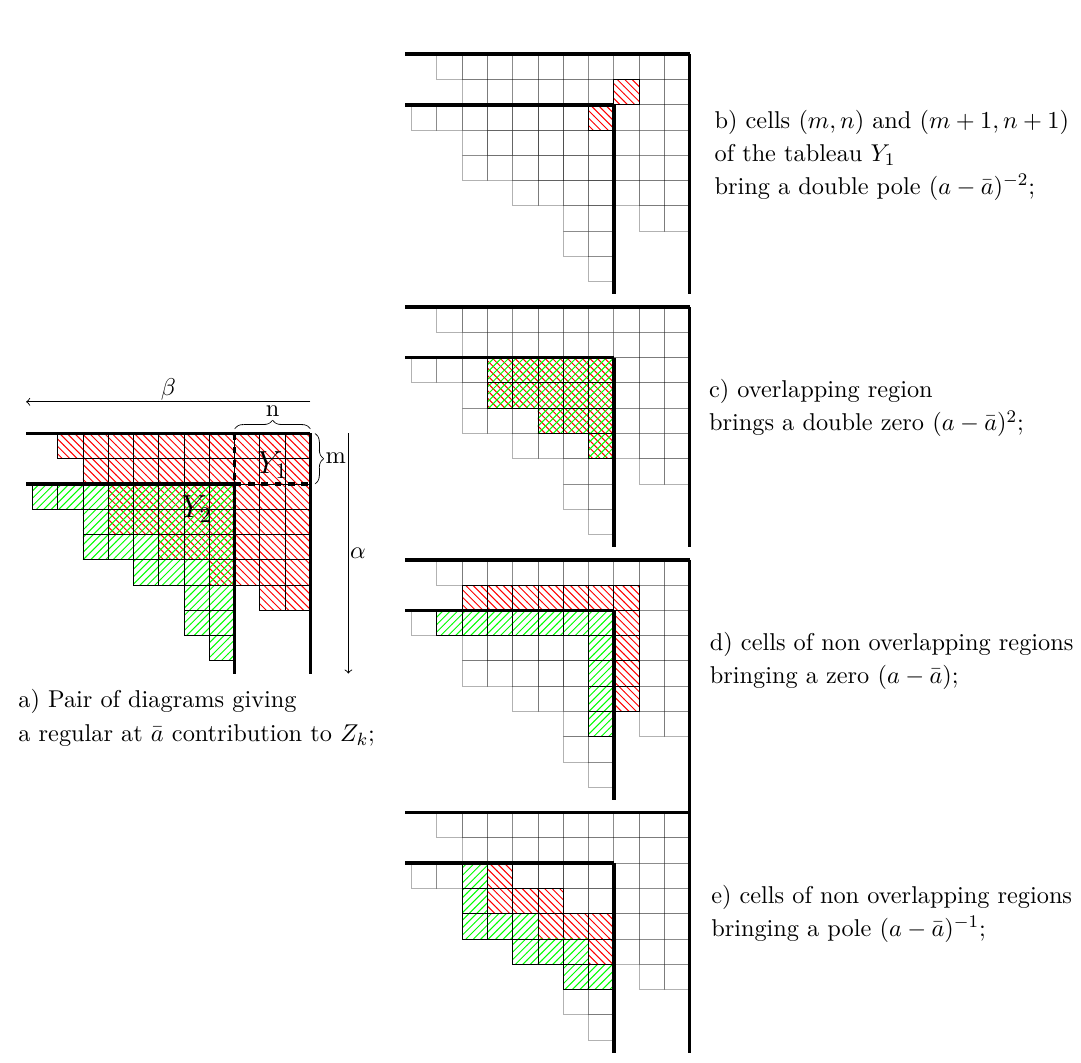
Figure 10 . Pair of diagrams giving a regular at ¯ a contribution to Z k and the sources of zeros and poles at ¯ a